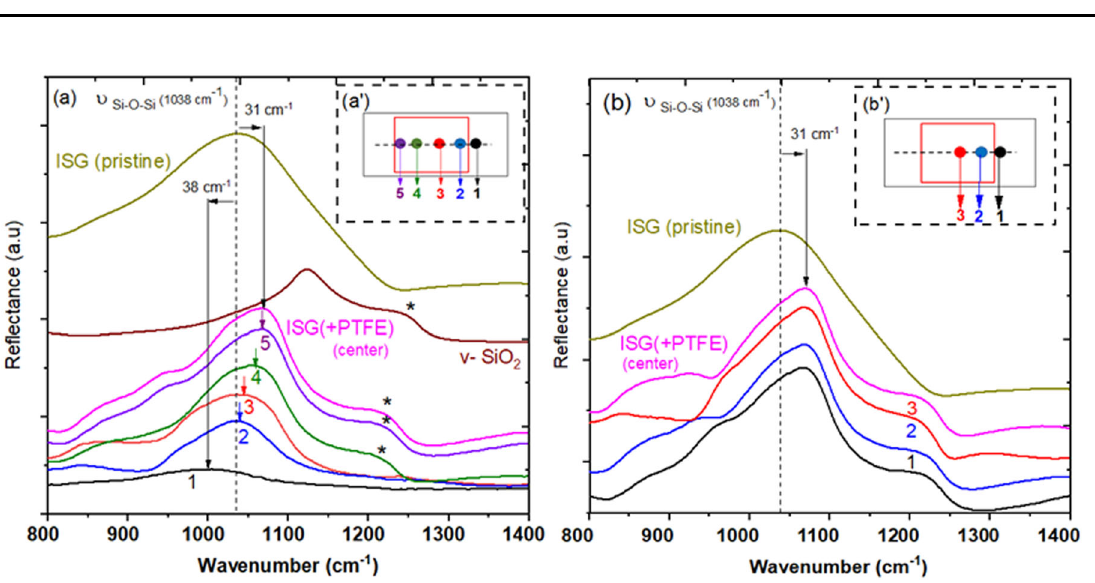
Fig. 8 SR-IR results displayed as re fl ectance acquired on ISG( + SS) samples. a ) Re fl ectance data for spots 1 through 5 for ISG( + SS) in 0.6 M NaCl along with a spectrum of pristine ISG and glassy SiO 2 . a ’ ) An illustration of the ISG( + SS) sample with numbers indicating the spots where spectra were acquired. The smaller rectangle in red represents the contact area of ISG with SS. A spectrum of an ISG( + PTFE) sample acquired at the geometric center of the sample is also included for comparison (in magenta color). Notably, spots 2 and 3 correspond to the vicinity of the large pits observed on the SS sample. b ) Re fl ectance data for spots 1 through 3 for ISG( + SS) in silica-saturated 0.6 M NaCl along with a spectrum of pristine ISG and a spectrum of ISG( + PTFE) for the same solution. b ’ ) An illustration of the ISG( + SS) sample with numbers indicating the spots where spectra were acquired and the smaller rectangle in red representing the contact region with SS.